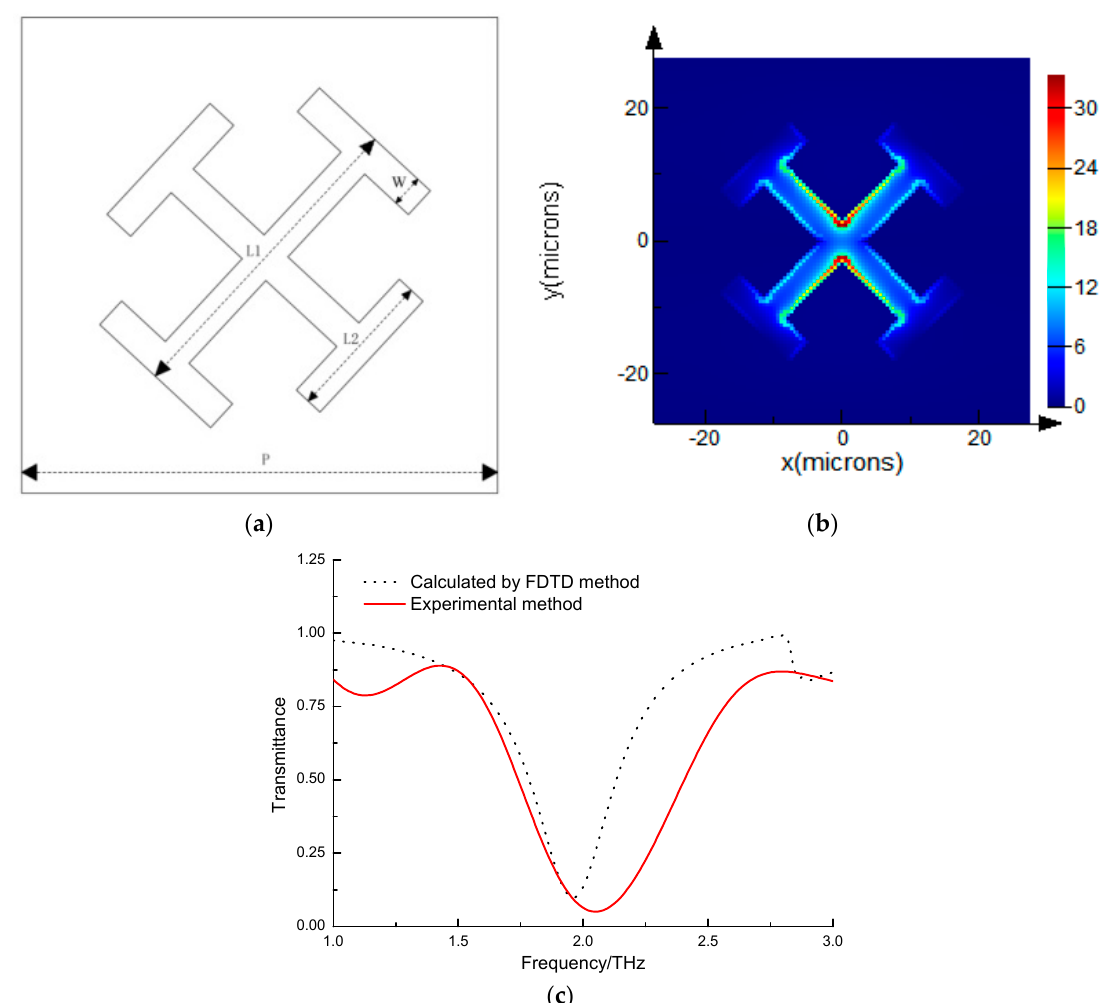
Figure 1. The metamaterial structure and the electromagnetic field distribution of the metamaterial structure based on FDTD method: ( a ) Size structure of the “X” shaped metamaterial; ( b ) electromagnetic field distribution of the “X” shaped metamaterial structure; ( c ) The transmittance spectrum of the “X” shaped metamaterial.